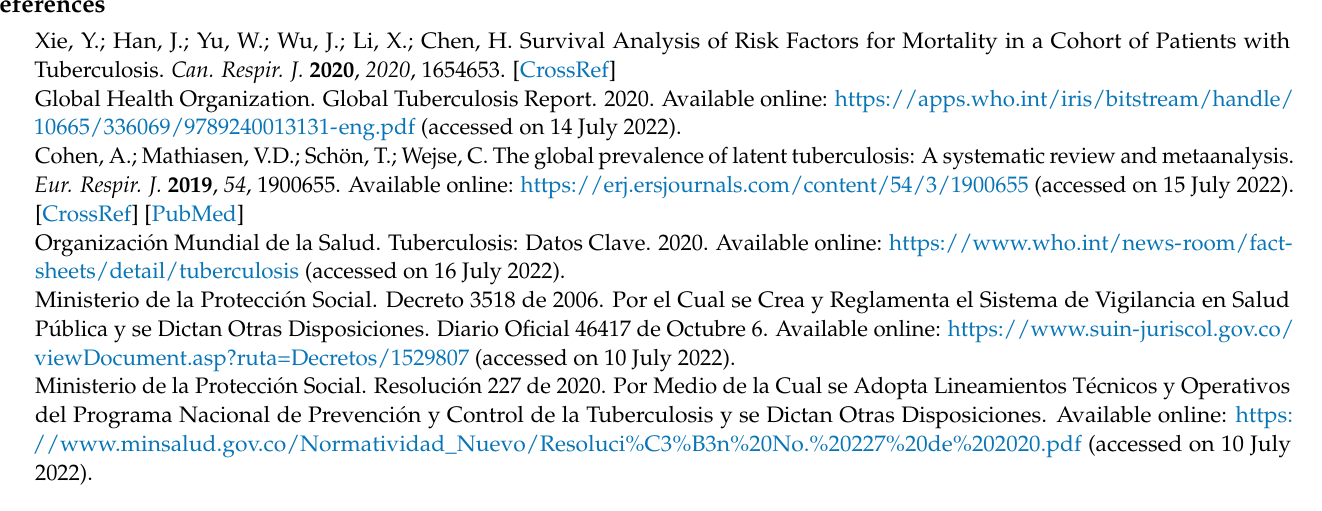
Figure A1. Georeferencing map with the rate of YYL, YLD and DALY by tuberculosis in Colombia,